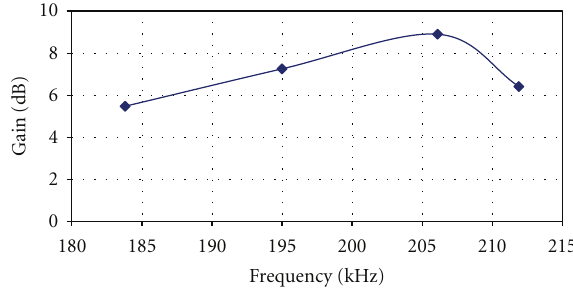
Figure 8: Link gain versus the operating frequency plots.